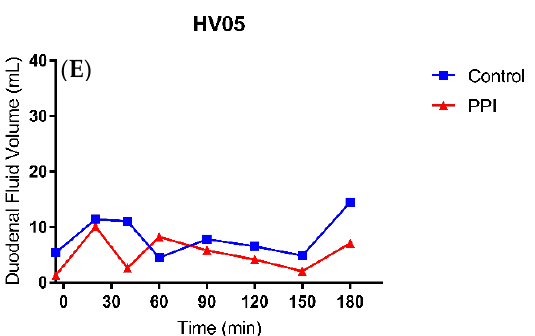
Figure 9. Individual duodenal fluid volume over time profiles for ( A ) HV01, ( B ) HV02, ( C ) HV03, ( D ) HV04 and ( E ) HV05 following oral intake of a Norvir tablet with 240 mL water in control (blue squares) versus PPI condition (red triangles).